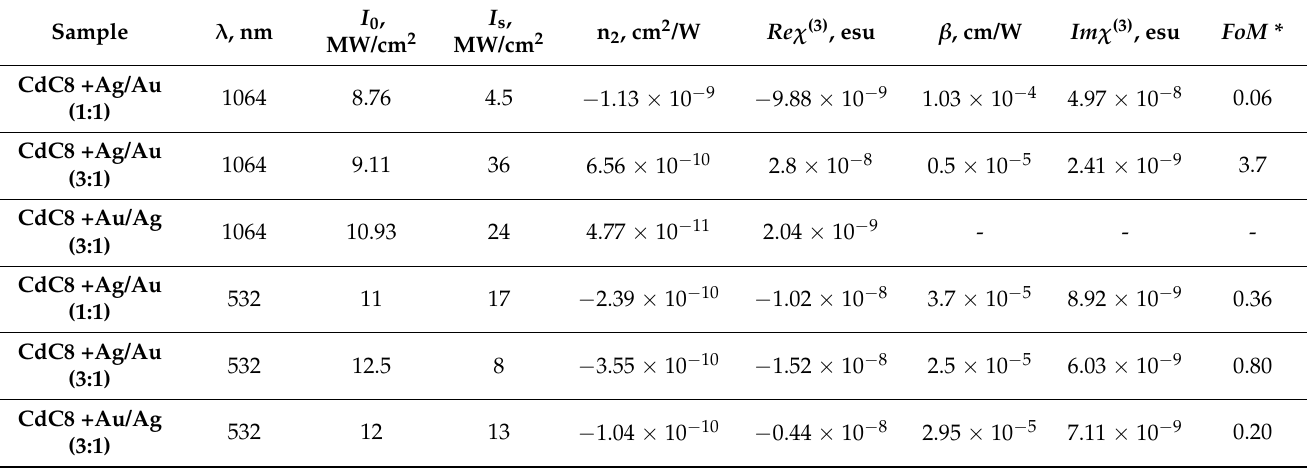
Table 1. Nonlinear optical parameters of the three nanocomposites (CdC8+Ag/Au (1:1)